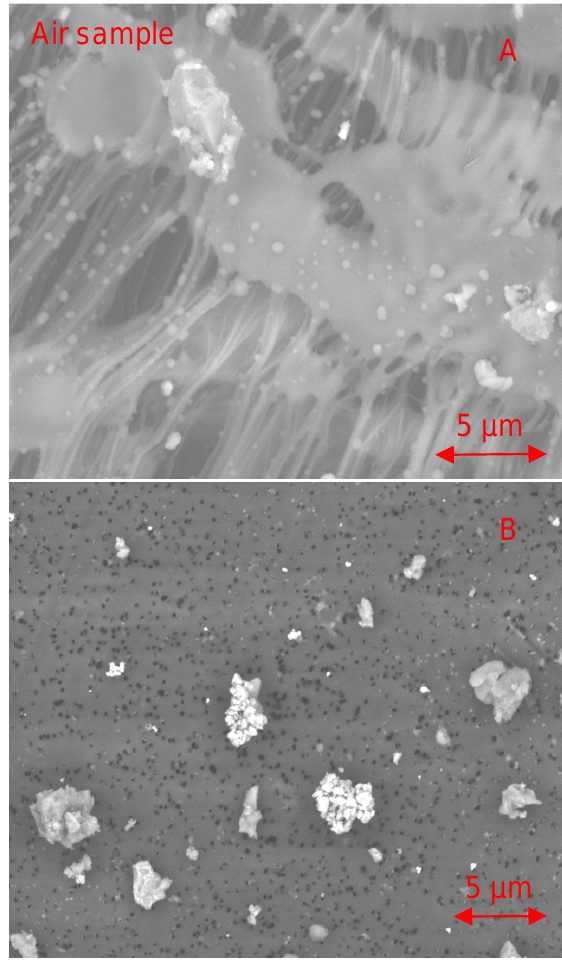
Fig. 5. SEM images of volcanic aerosol collected on a TSP filter at the Jungfraujoch (18 April 2010, 17:10–19 April 2010, 17:10UTC+1). Top image: original sample. Bottom image: sample after filtration and redeposition on a Nucleopore filter.